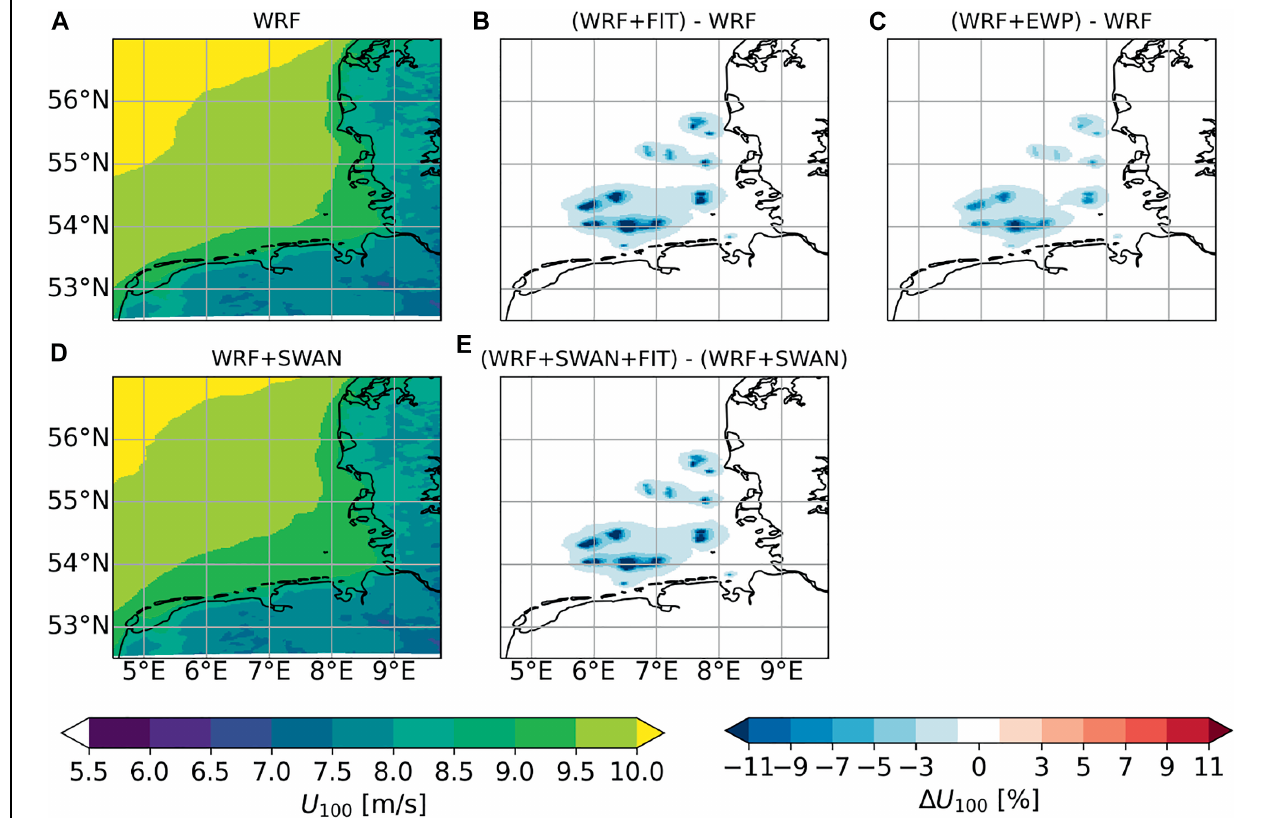
FIGURE 9 | (A,D) Simulated long-term mean wind speed at 100 m height for (A) WRF and (D) WRF + SWAN and (B,C,E) relative reduction of wind speed based on (B) (WRF + FIT)-WRF, (C) (WRF + EWP)-WRF and (E) (WRF + SWAN + FIT)-(WRF + SWAN) all normalized by the respective subtrahend.